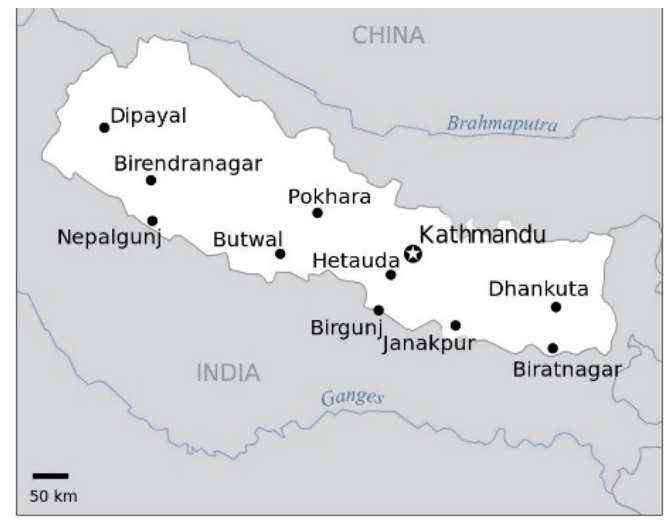
Figure 2. Map of major cities in Nepal.